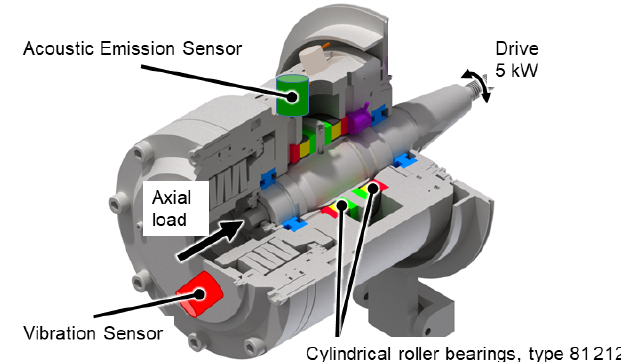
Figure 5. Thrust bearing test bench: position of the AE and vibra- tion